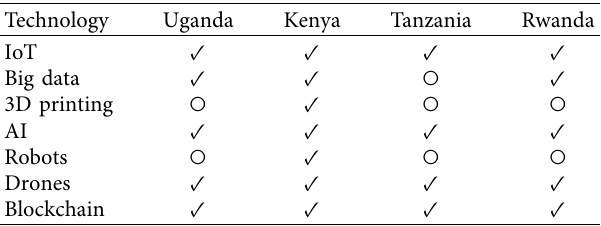
Table 13: Industry 4.0 technologies with startups in the EAC. Technology